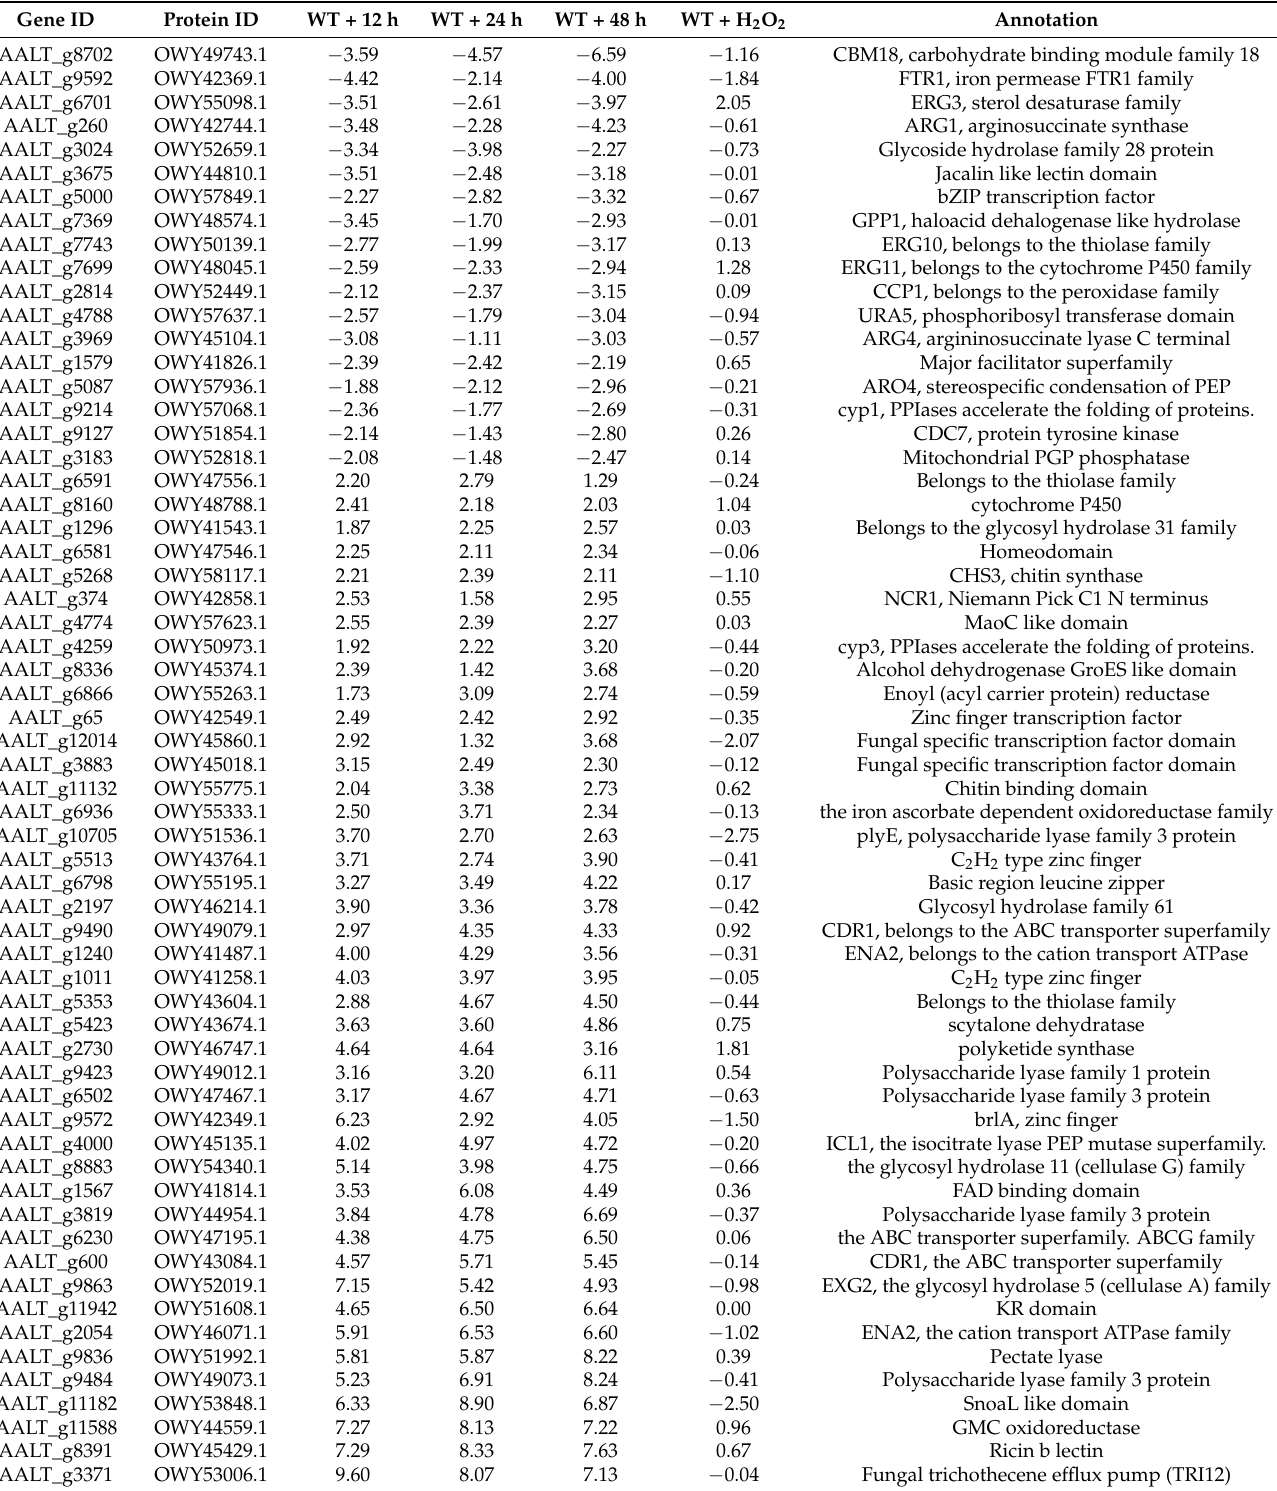
Table 1. The genes of Alternaria alternata related to plant-pathogen